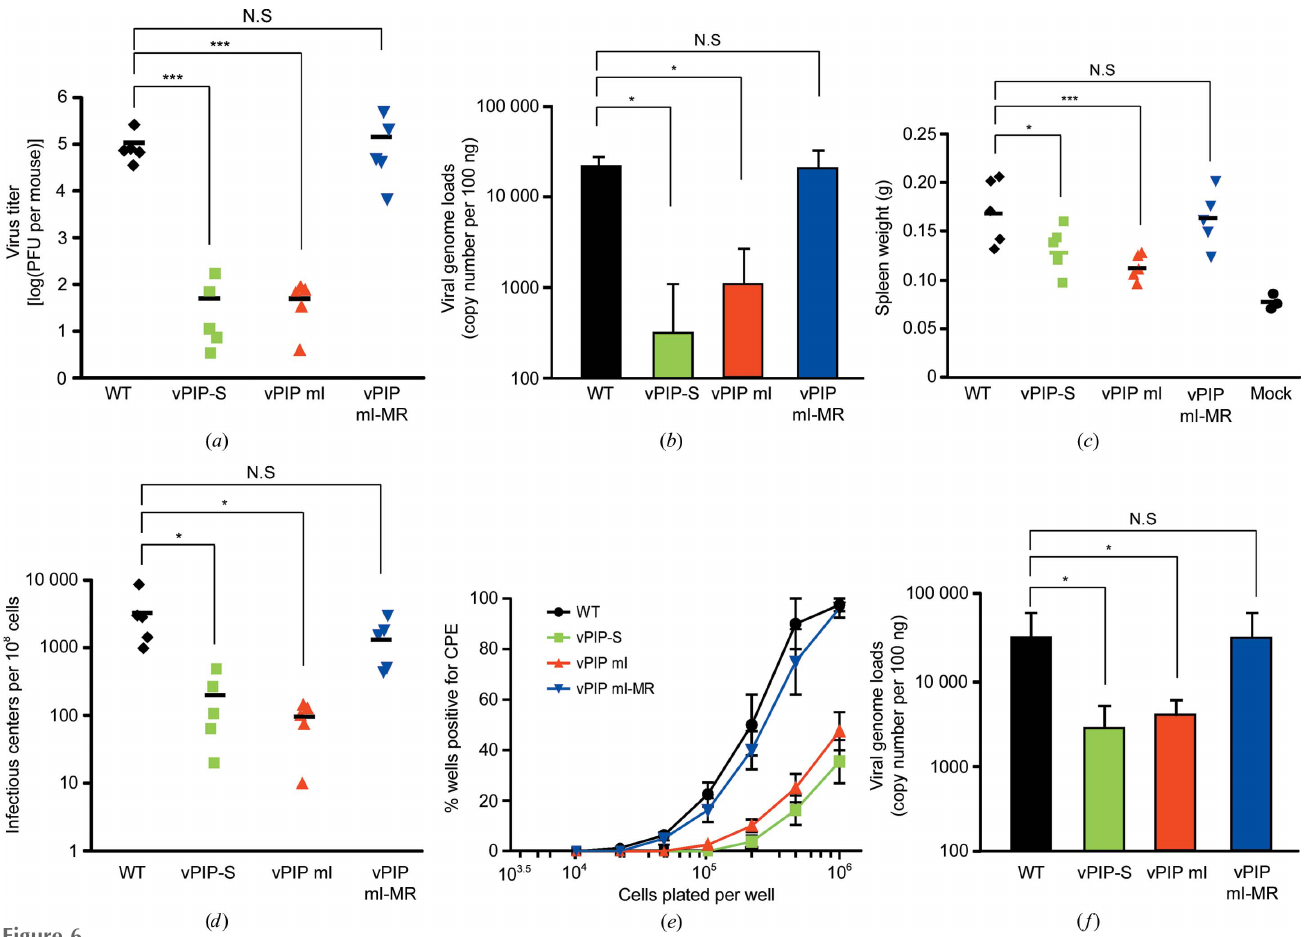
Figure 6 In vivo acute and latent infections by the mutant virus (vPIP mI). BALB/c mice were intranasally infected with 1000 plaque-forming units of WT, vPIP-S, vPIP mI or vPIP mI-MR virus. ( a , b ) Acute infection with the vPIP mI mutant in the lungs. At 6 d post-infection the lungs were excised and homogenized to determine lytic viral titers in plaque assays ( a ). Each symbol represents the viral titer from the lung tissue of individual mice, with the bar showing the mean value ( n = 5 in each group). The genomic DNA samples were extracted from the lungs of infected mice. The viral genome copy numbers were quantitated by real-time PCR ( b ). The average viral genome copy numbers are shown with the standard error of the mean. ( c – f ) Latent infection with the mutant (vPIP mI) in the spleen. At 17–18 d post-infection, the spleens were excised and their weights were measured ( c ). The splenocytes were prepared and examined for the frequency of cells reactivating the virus by ex vivo infectious-center assays ( d ) and a limiting-dilution assay ( e ). In the limiting-dilution assay, each symbol represents the average percentage of wells positive for cytopathic effects with the standard error of the mean ( n = 5 in each group). In infectious-center assays, each symbol represents the viral titer from individual mice, with the bar showing the mean value. The genomic DNA samples were extracted from splenocytes of the infected mice. The viral genome copy numbers were quantitated by real-time PCR ( f ). The average viral genome copy numbers are shown with standard errors of the mean ( n = 5 in each group). Statistical analysis was performed by a two-sided Student’s t-test (* denotes P < 0.05 and *** denotes P <